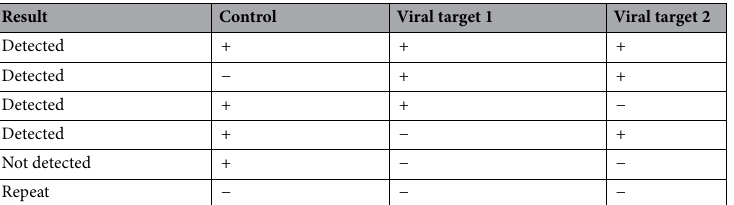
Table 2. Decision table based on bioinformatics outputs to generate patient’s qualitative results. A plus symbol indicates that the threshold of 10 reads was hitched for a specific SARS-CoV-2 or MS2 target, while a minus symbol indicates